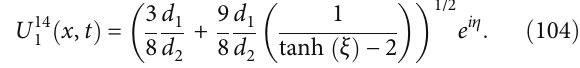
Figure 9: The graphical simulation representation of j U 9 = 0 : 6, w = 0 : 01 δ 4 2